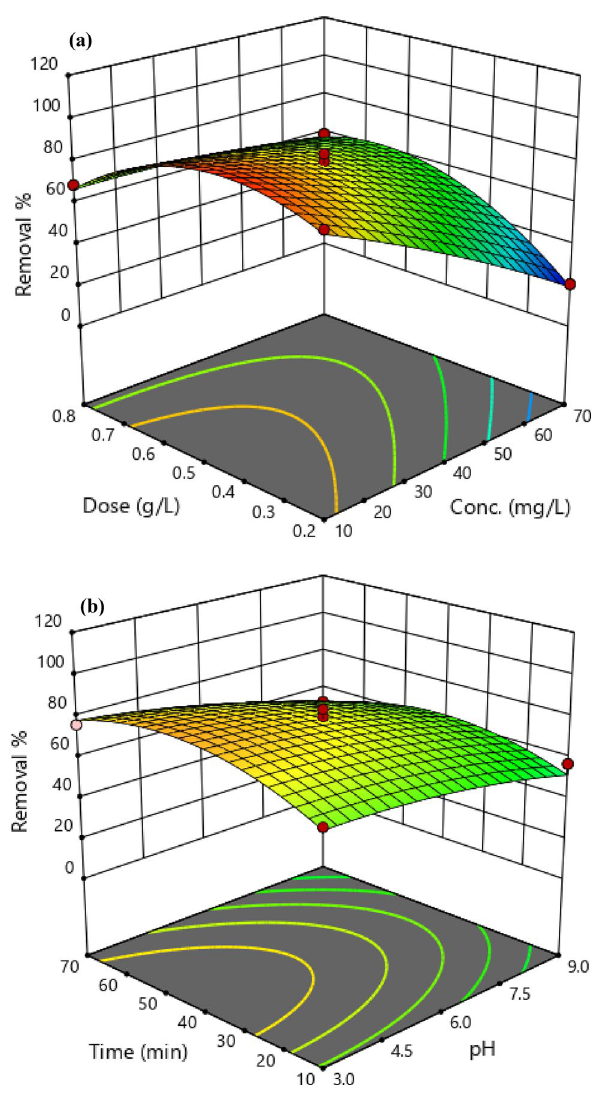
Fig. 6 Response surface plot about the effects of a dose versus Conc. RR-141, b pH versus